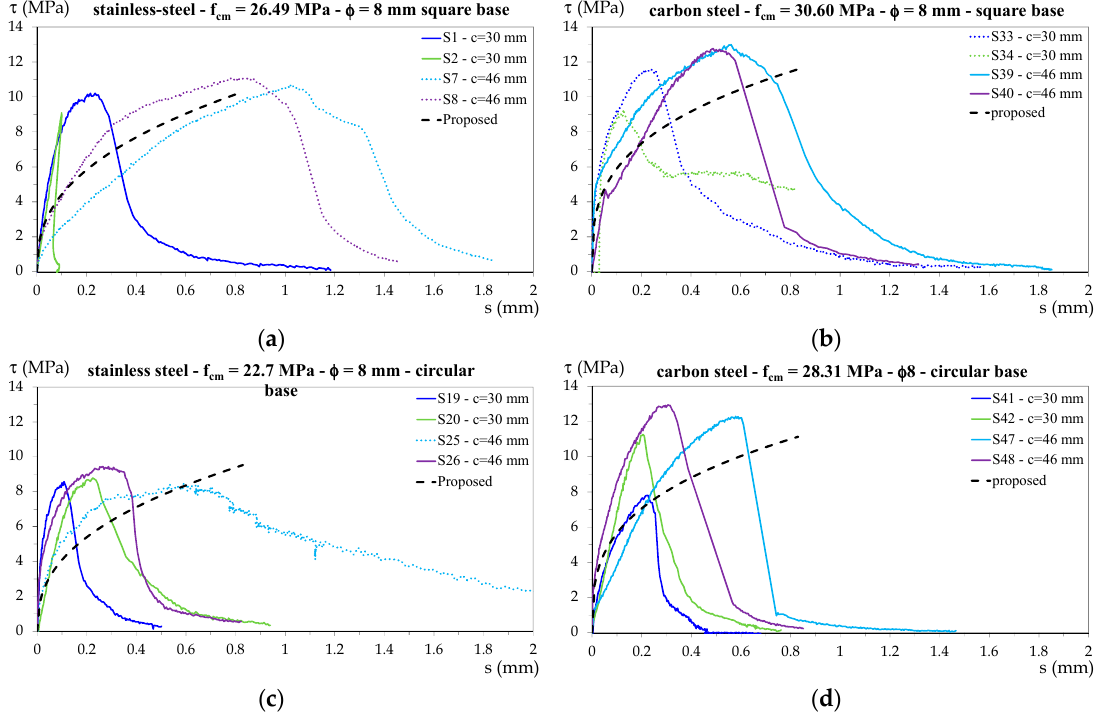
Figure 13. Bond stress–slip diagrams for specimens with different cover: ( a , c ) specimens with stainless steel bars; ( b , d ) specimens with carbon steel bars. Table 3. Parameters of the proposed bond stress–slip relationships.